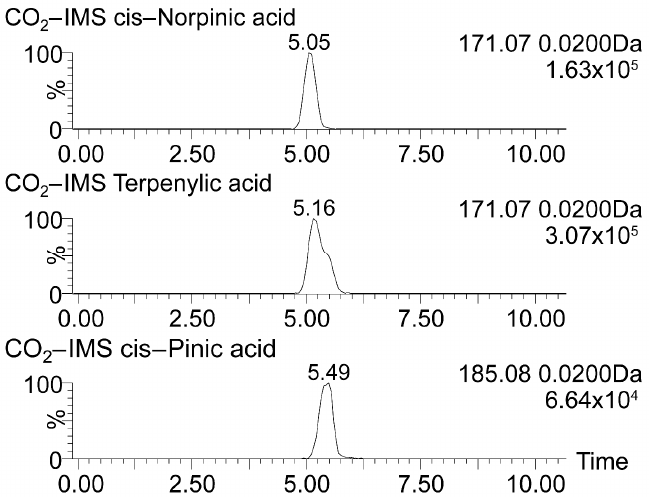
Figure 5 Figure 5. CO 2 - driftgrams of standard compounds. The top panel shows cis -norpinic acid ( m / z 171, C 8 H 11 O 4- ), the middle panel shows terpenylic acid ( m / z 171, C 8 H 11 O 4- ), and the bottom panel shows cis -pinic acid ( m / z 185, C 9 H 13 O 4- ). The time axis is in milliseconds.